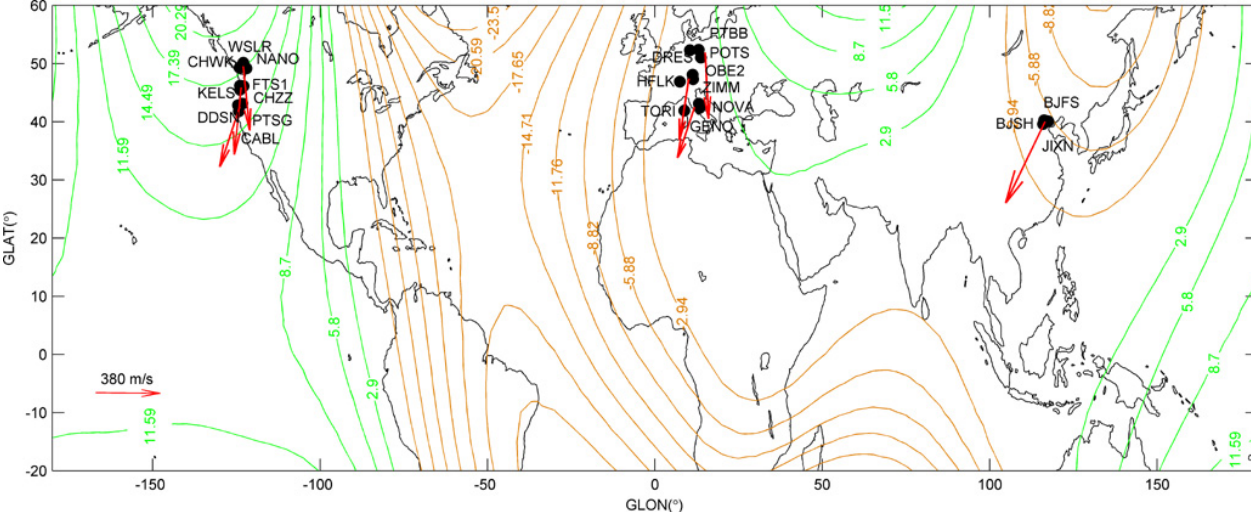
Fig. 5. Propagation parameters of LSTIDs on 9 November 2004. The horizontal phase velocity of LSTID was represented by the length of the red arrow, and the propagation azimuth of LSTID was indicated by arrow’s direction. The dots showed the chosen locations of 7arrays, and eastward (westward) declination of the geomagnetic field was presented by the green (brown) contour